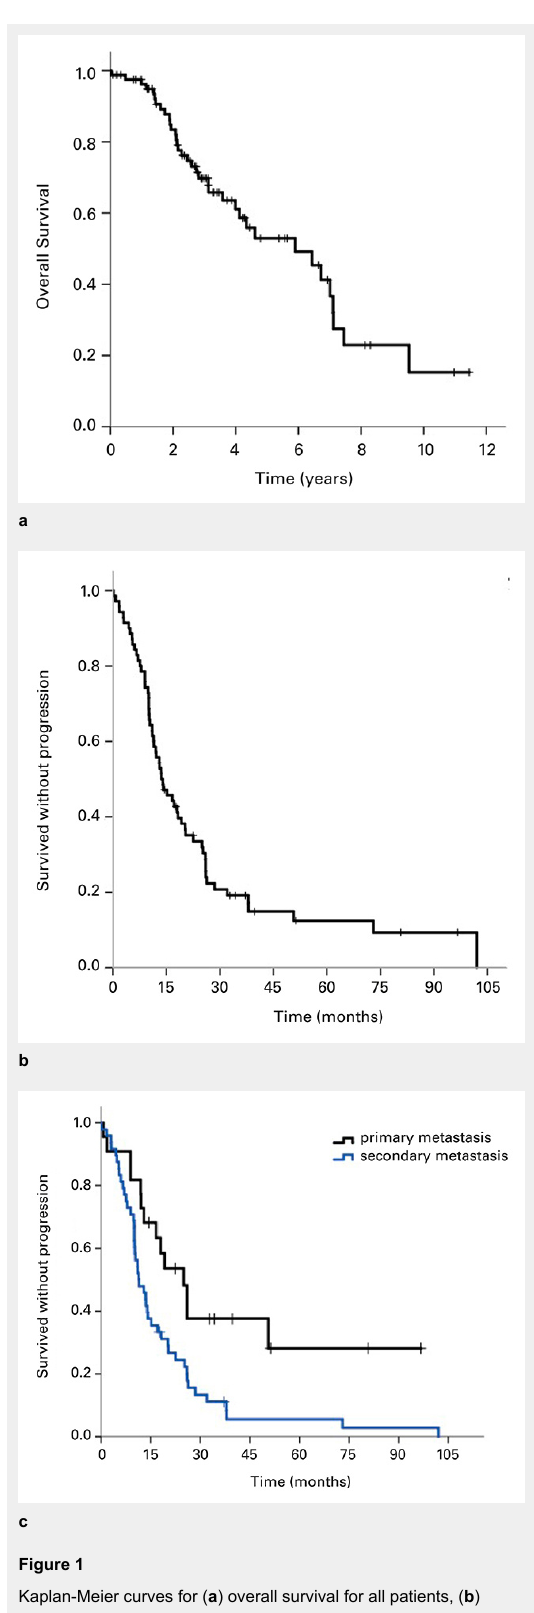
Figure 1 Kaplan-Meier curves for ( a ) overall survival for all patients, ( b ) progression-free survival (n = 70), and ( c ) progression-free survival of patients with primary metastatic disease vs patients with secondary metastatic disease, p =